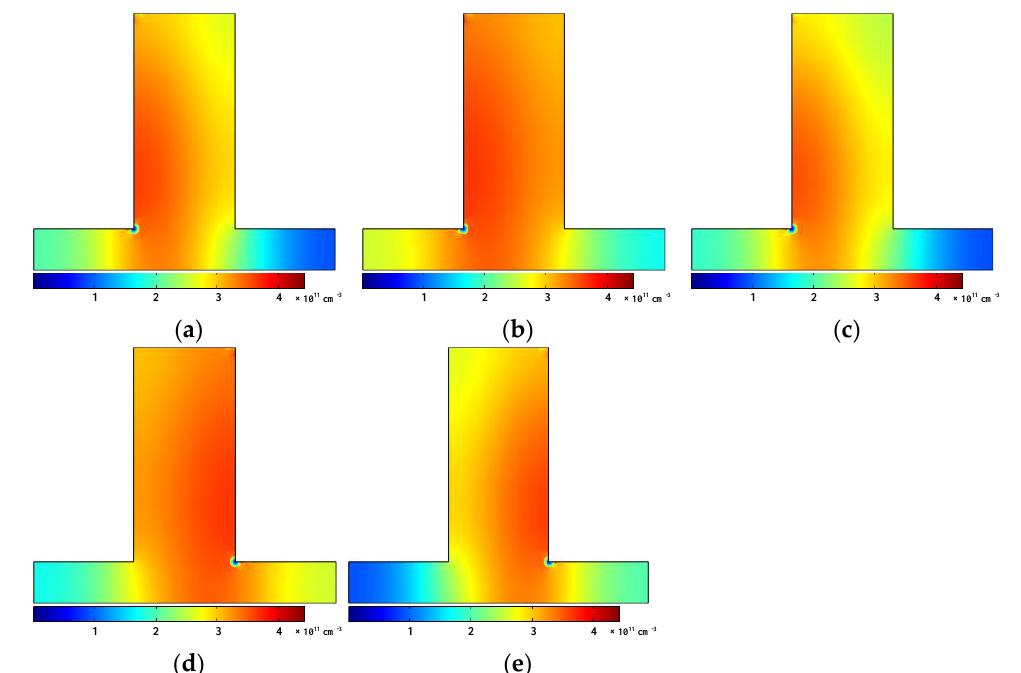
Figure 16. Spatial distribution of the O 2 density for times ( a ) 2 ms, ( b ) 6 ms, ( c ) 10 ms, ( d ) 14 ms, and ( e ) 18 ms for the reactor at AC 22 kV voltage and 1 cm distance between electrodes.